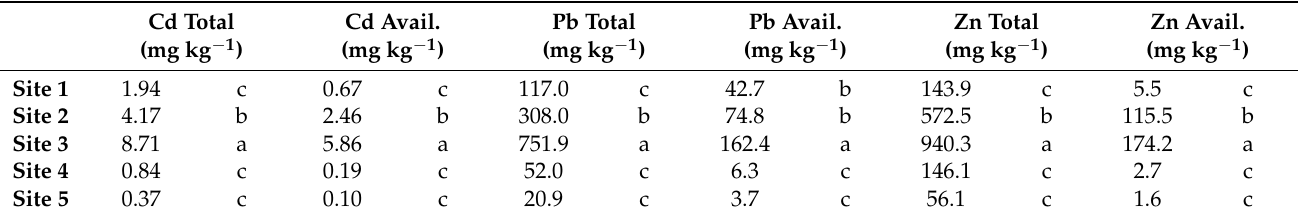
Table 1. Total and available Cd, Pb, and Zn in soil of CANOPAES project: Sites 1–3 potentially polluted; 4,5